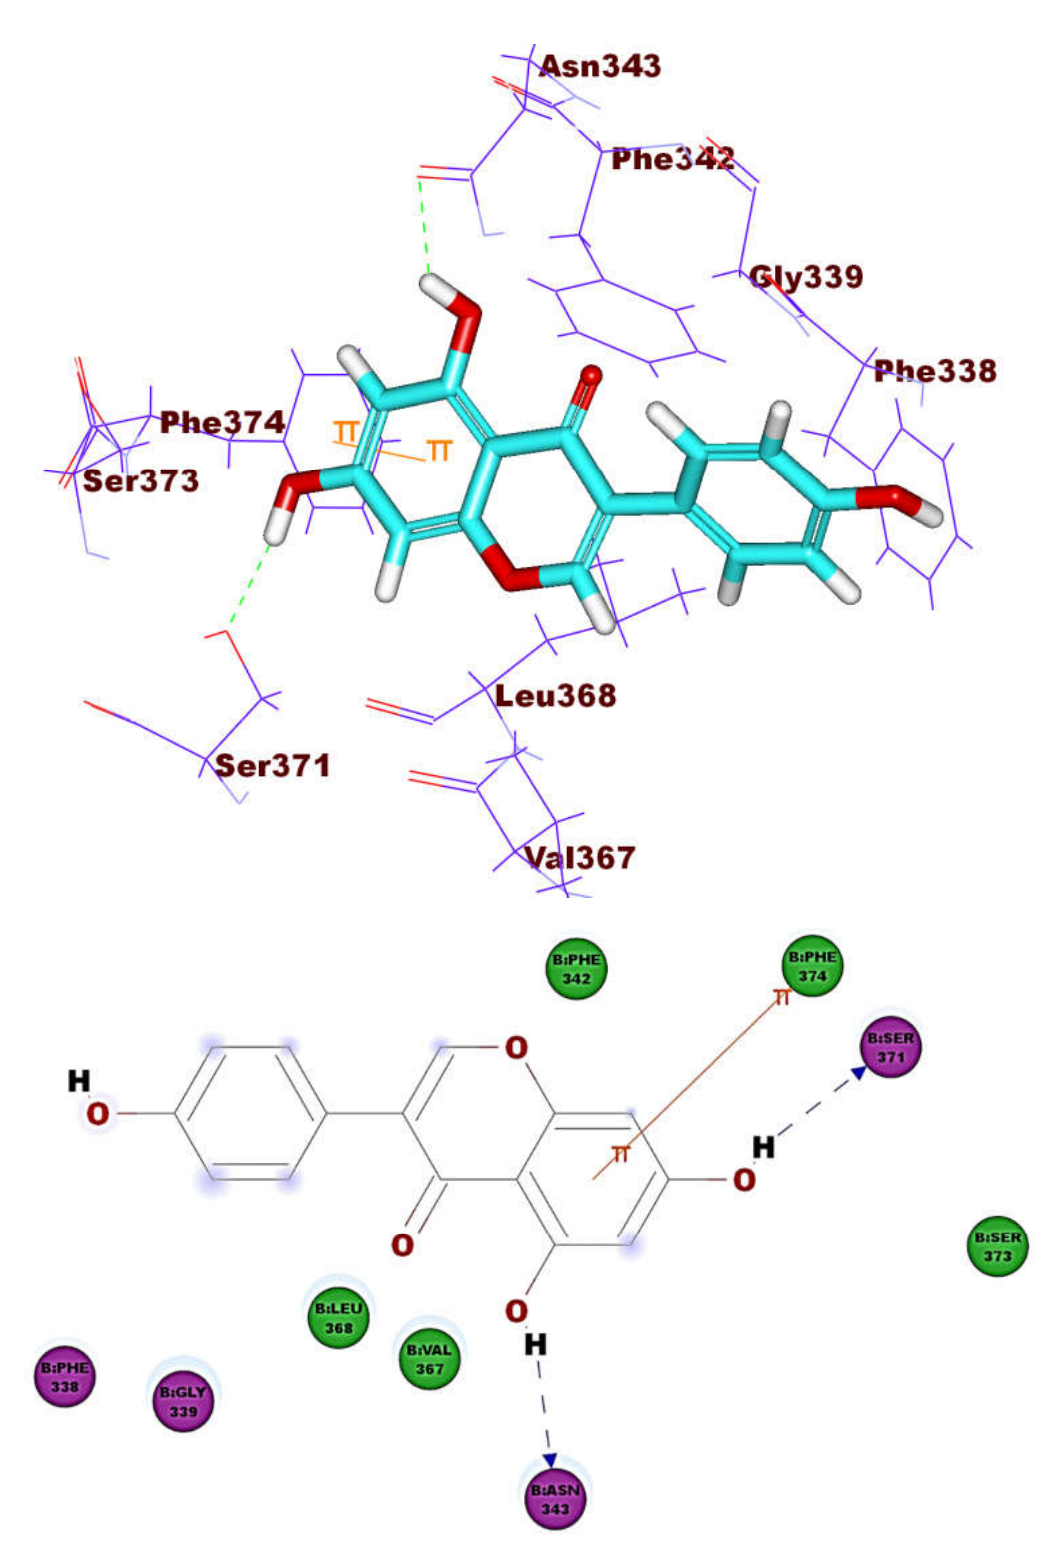
Figure 5. Compound 1 docked into ACE-2, forming two H. bonds with Ser371 and Asn343.